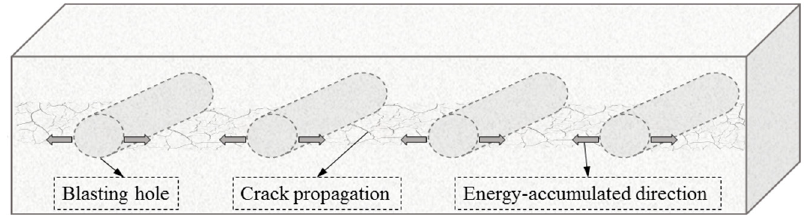
Figure 5. Energy control of the directional roof fracturing technique.